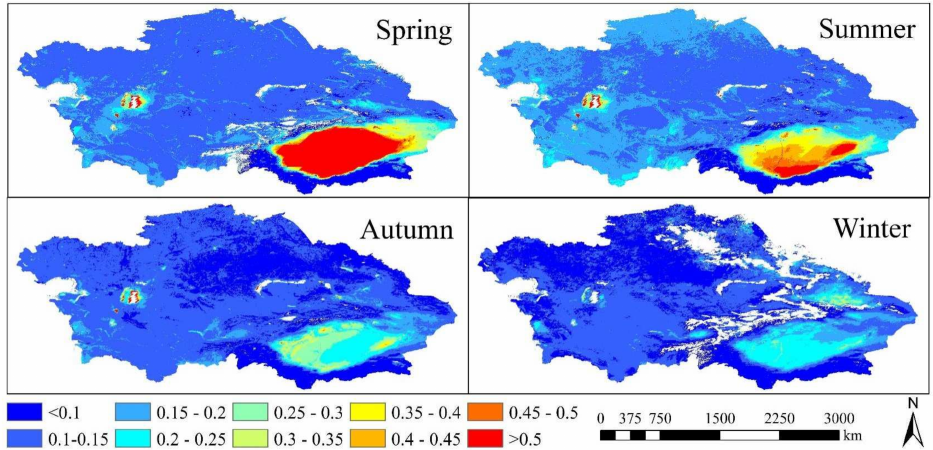
Figure 9. Distribution of the AOD in the four seasons in Central Asia.